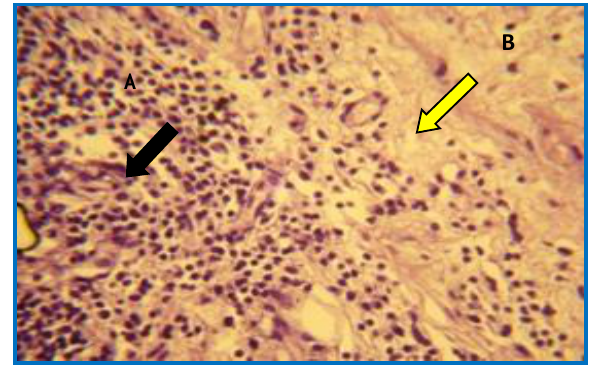
Figure, 9: There is neutrophils infiltration in subepithelial layer (A), and fibrin deposition in Stroma (B). Group B, seven days post operation (H and E 20 X).